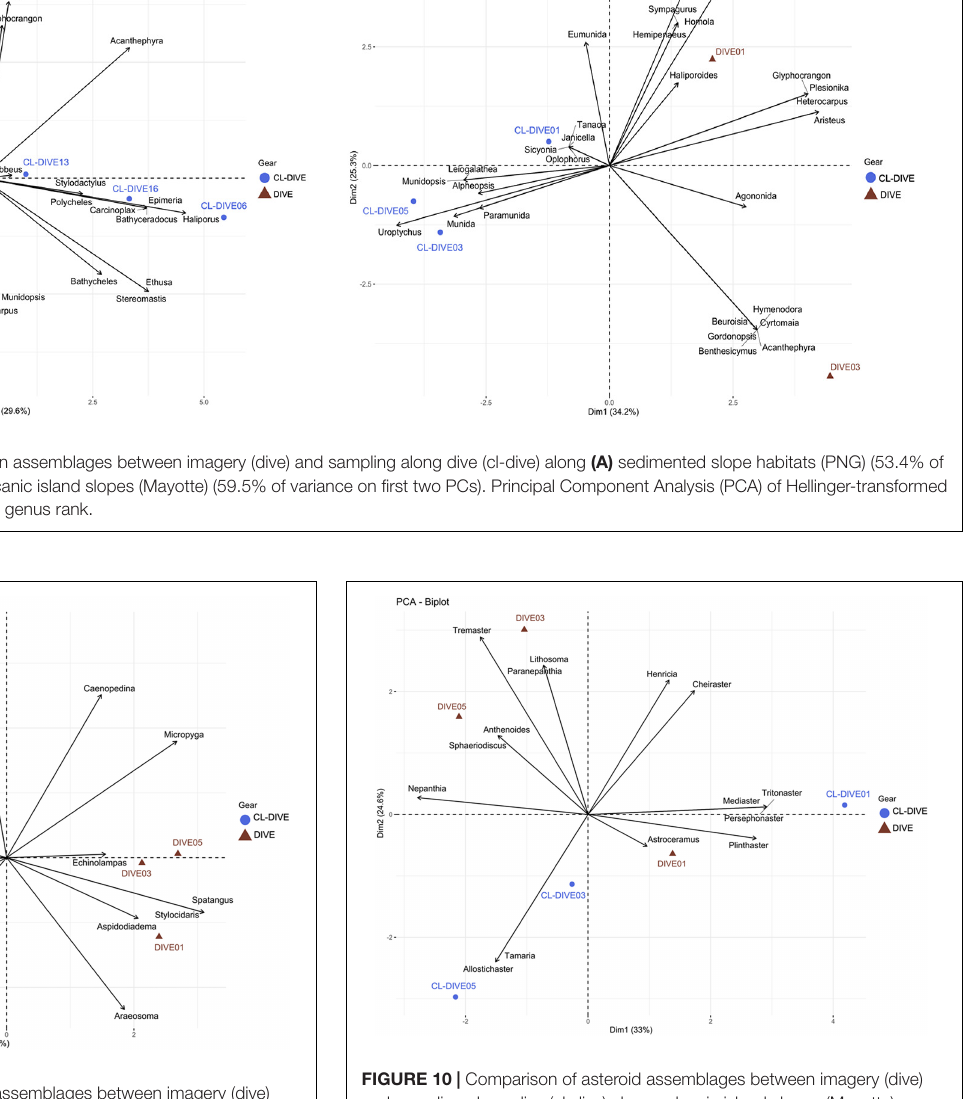
morphological characters from images. In the physical